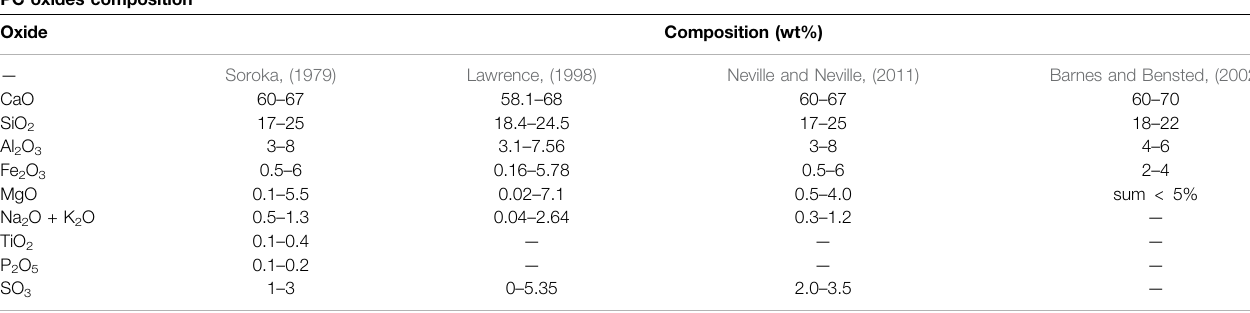
TABLE 2 | PC oxides